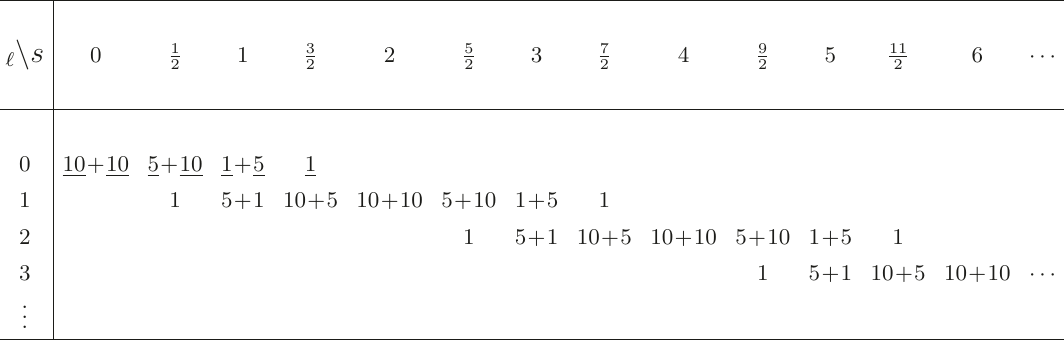
Table 2 . The spectrum of physical fields carrying antisymmetric in the case with O ( N ) internal M symmetry. For s 1 fields, the level ℓ is related to s by s = 2 ℓ + 1 k/ 2 + r/ 2 . The values of ℓ are ≥ − assigned to spin-0, 1/2 fields such that fields belonging to the same supermultiplet are labeled by the same ℓ . We have underlined the fields belonging to the gravitino multiplet. This table also provides the spectrum of physical fields with symmetric in the case with USp(2 N ) internal J M